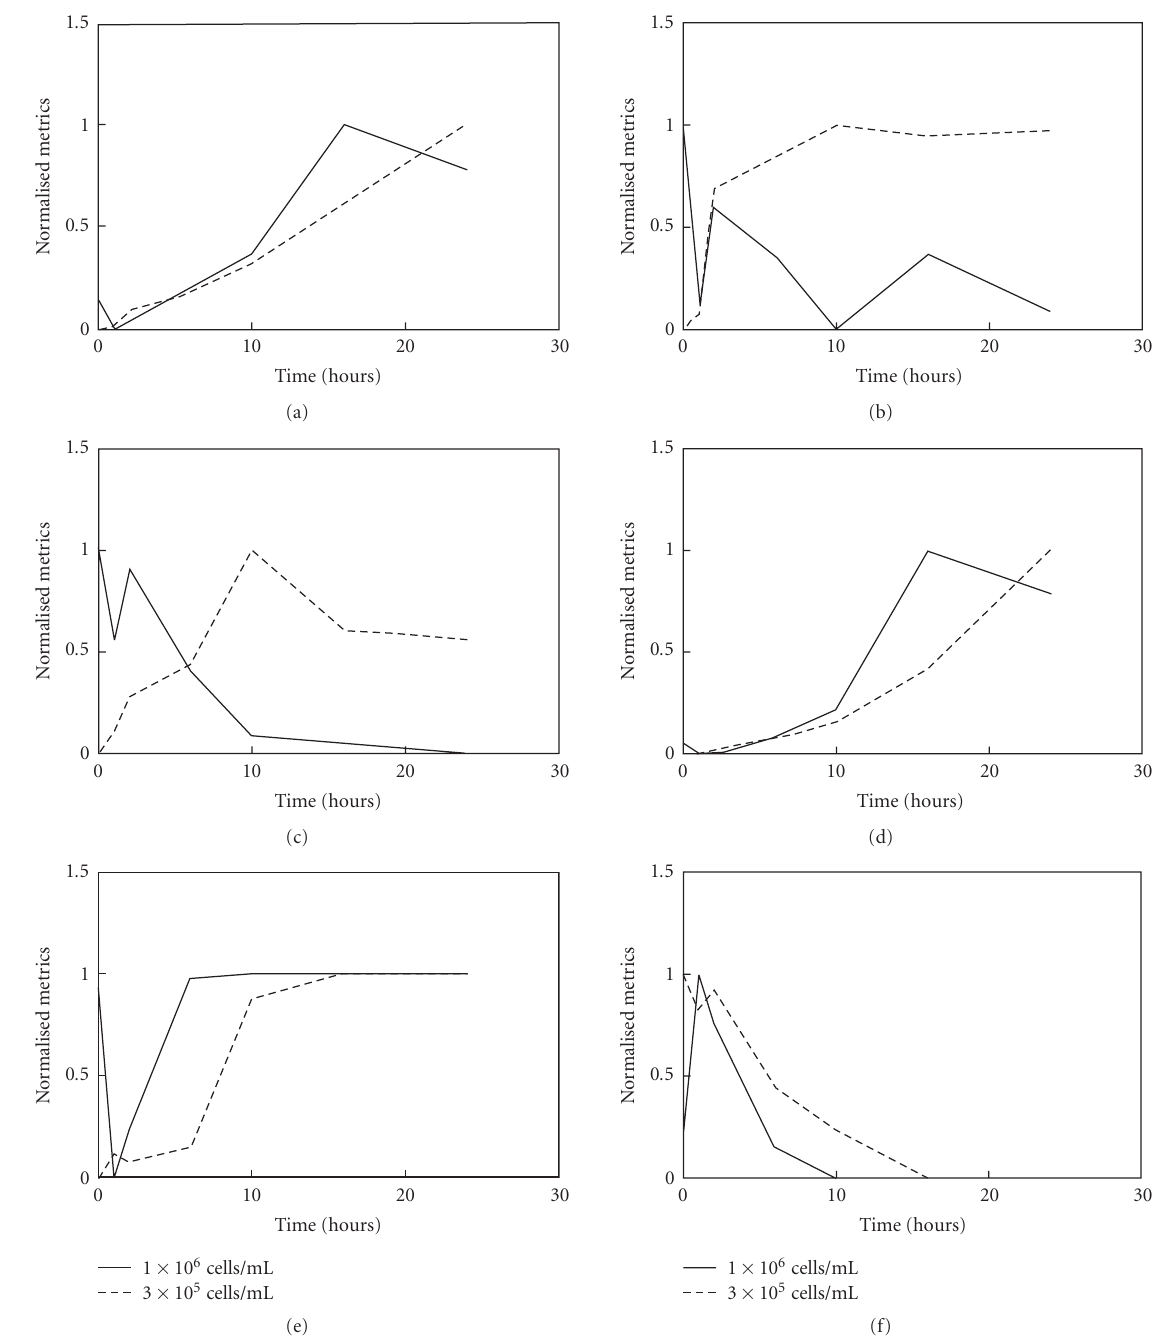
Figure 6: Cell-graph mining extracts metrics which represent the topological changes in 3D cell culture as a function of cell density. The e ff ect of change in cell density from 3.0 × 10 5 to 1.0 × 10 6 on our graph features was plotted. (a) Average degree. (b) Clustering coe ffi cient. (c) Diameter. (d) Number of edges. (e) Giant connected ratio. (f) Number of connected components over the 24-hour time course. The extracted metrics have been normalized from